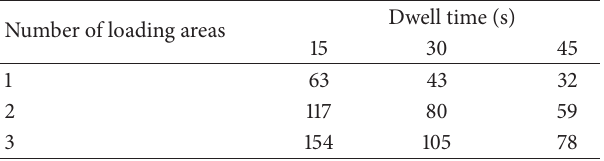
Table 1: Capacity of on-line linear stops